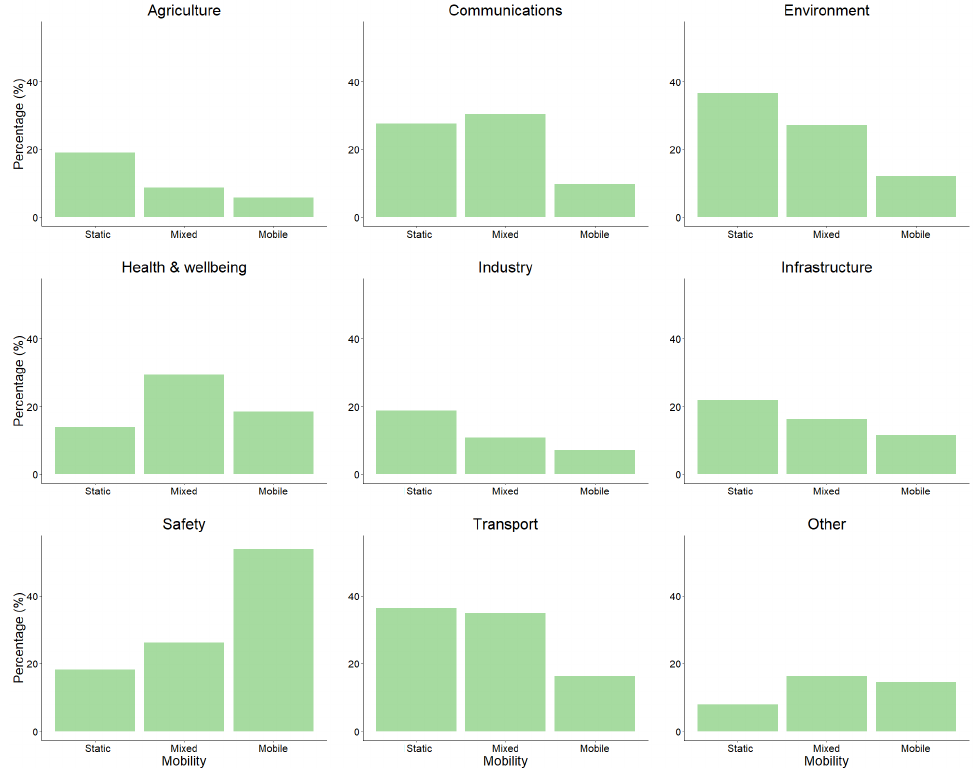
Figure 22. Deployment distribution between node mobility and deployment